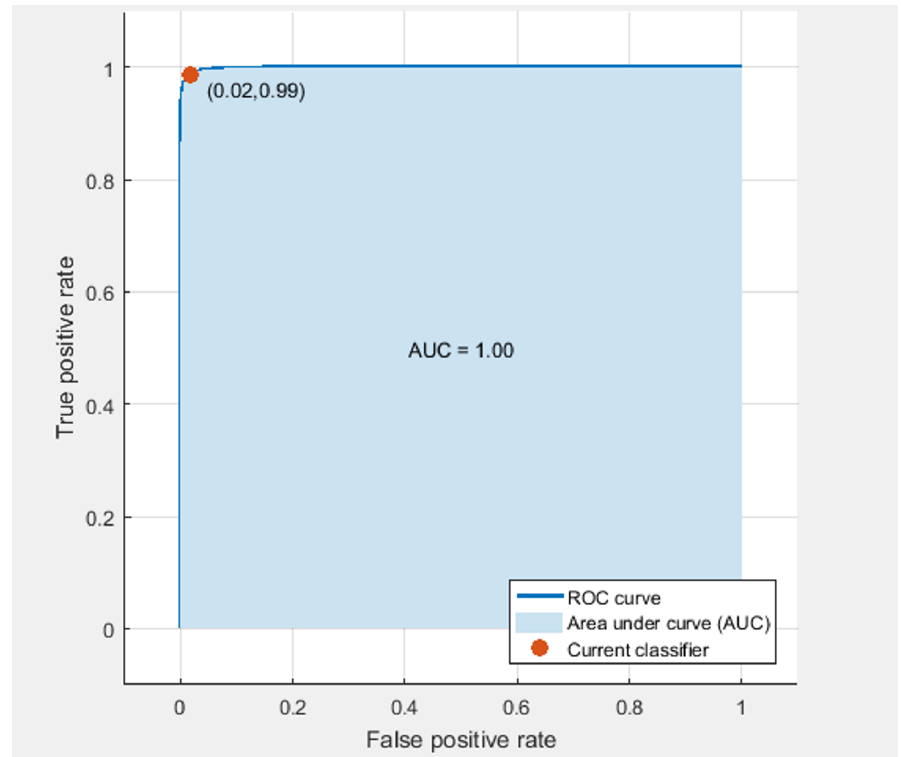
Figure 22. ROC of ACC and EMG measured from biceps brachii muscle bagged tree